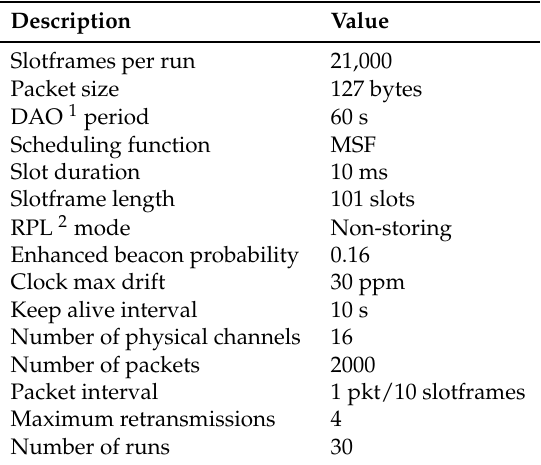
Table 1. General parameters of the